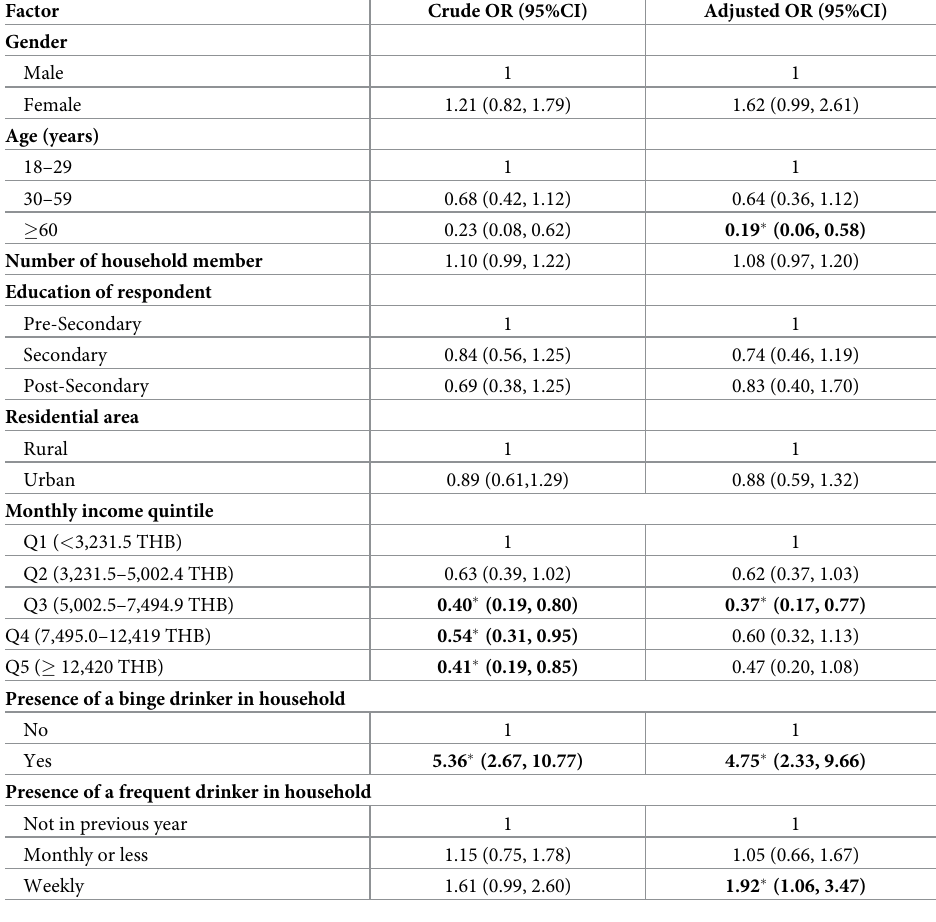
Table 4. Factors influencing alcohol-related harms to